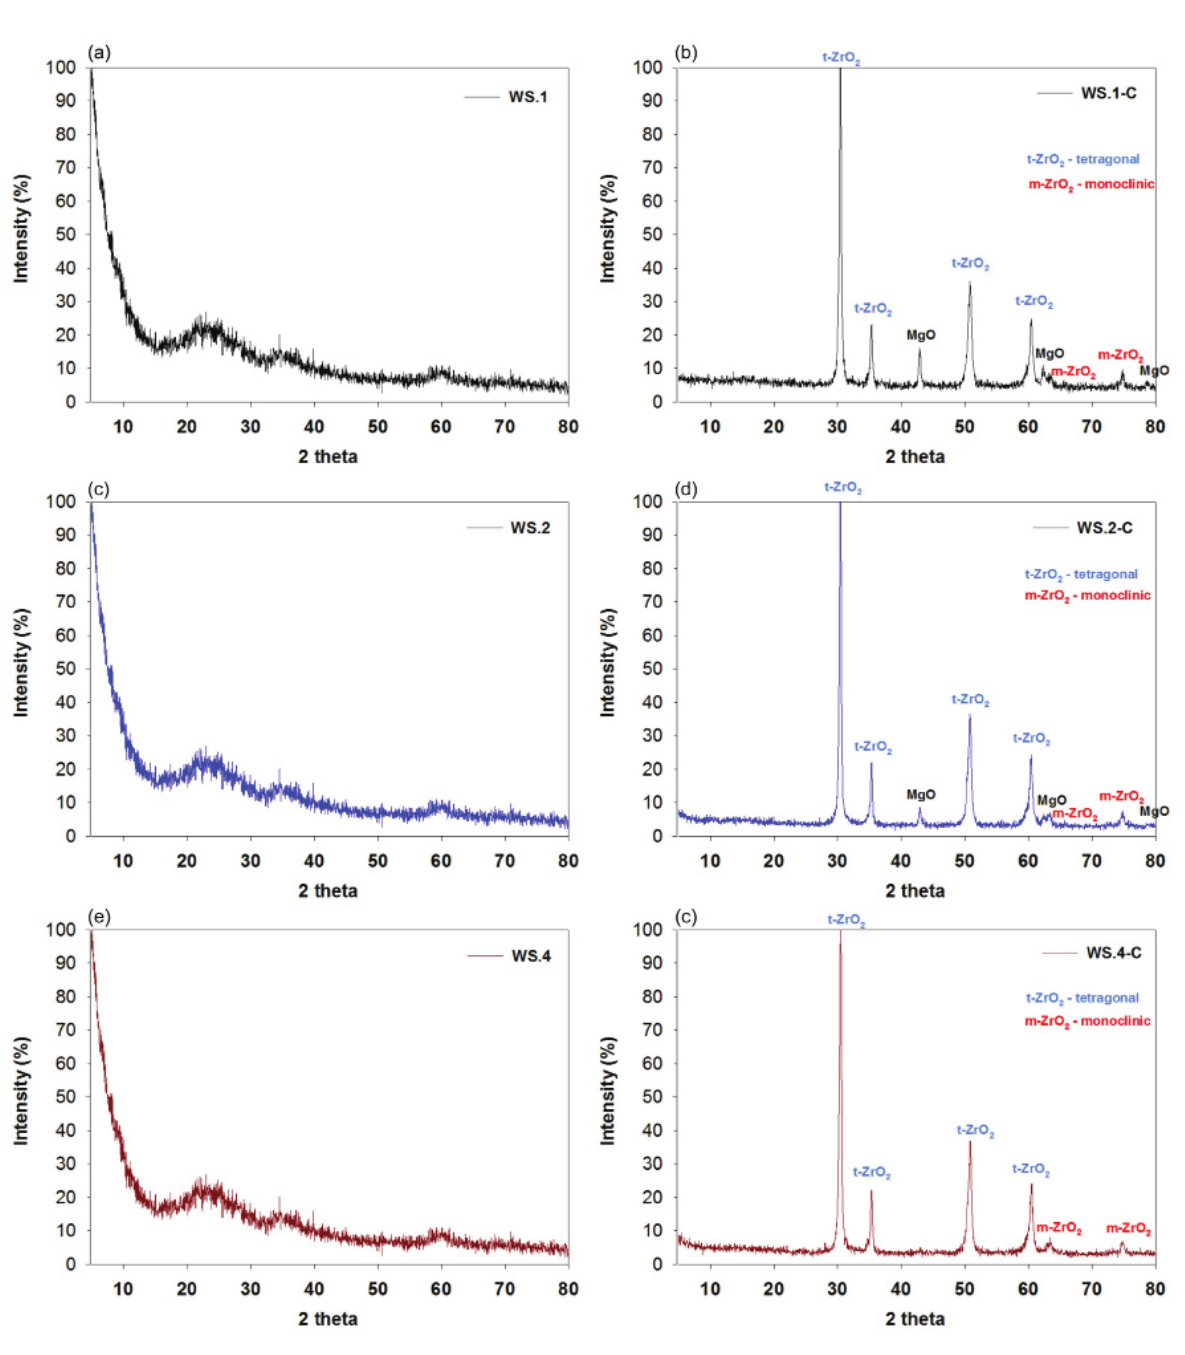
oxide materials: uncalcined (a, c, e) and calcined at 800 ºC for 2 h (b, d, Figure 5: XRD patterns of MgO-ZrO 2